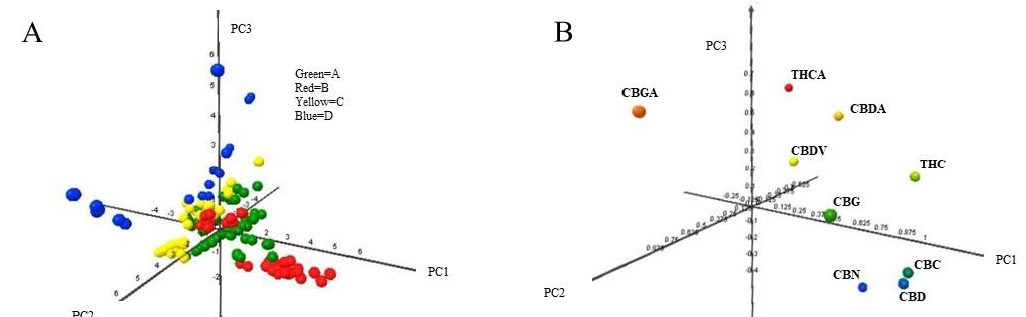
Figure 2. Scores plot ( A ) and loadings plot ( B ) obtained from the PCA on the matrix data of the 161 hemp samples (in the matrix rows) and the nine cannabinoids analyzed (the matrix columns). Plots of the first three components (explained variance: PC1 = 42.7%; PC2 = 15.8%; PC3 = 14.9%; total = 73.4%). Data have been auto-scaled (zero mean and unitary variance) before PCA. The four Hemp retailers are marked with different colors: Green = A; Red = B; Yellow = C; Blue = D.